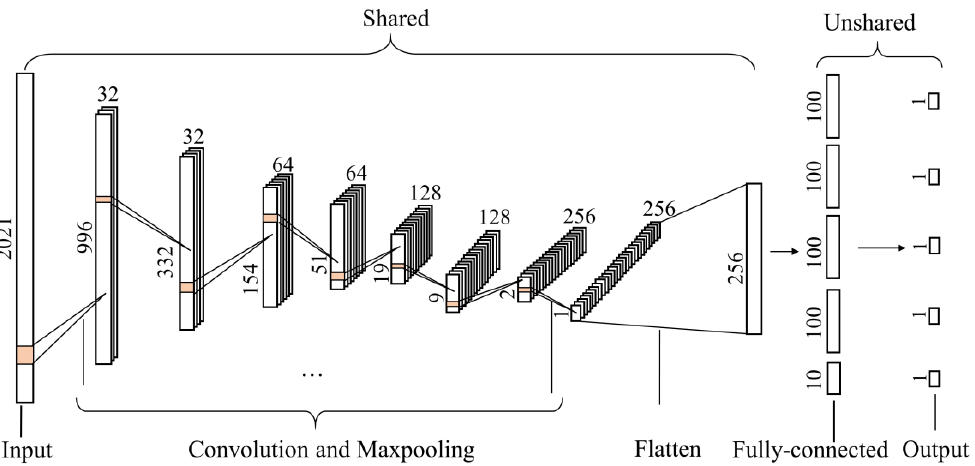
Figure 4. The structure of multitask one-dimensional convolutional neural network to predict soil properties and vegetation coverage (VC). Table 2. Parameters of each layer used in the multitask one-dimensional convolutional neural net- work (1DCNN) model.